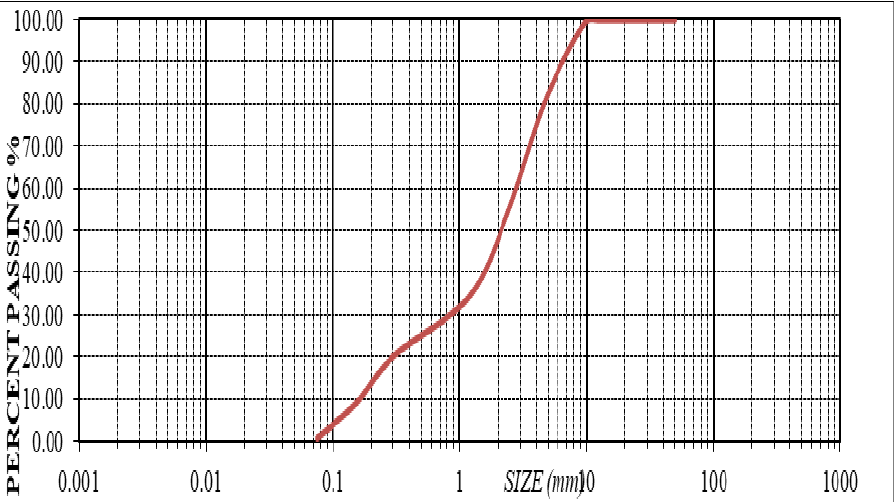
Fig. 1. Report of sand grading experiment.